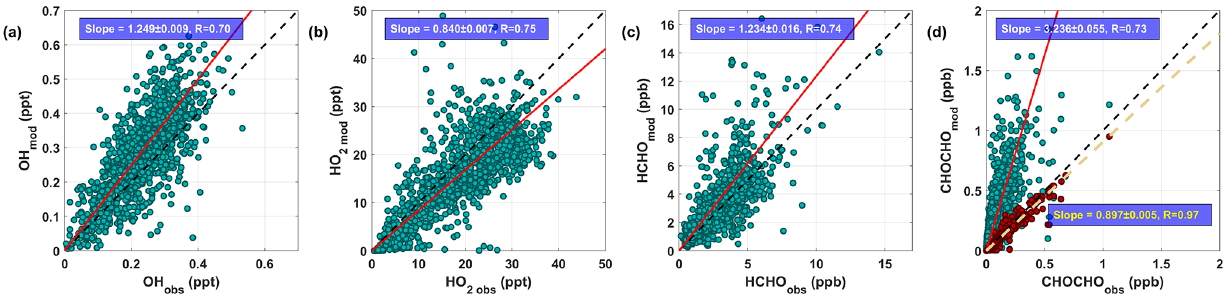
Figure 2. Comparison of measured and modeled (a) OH, (b) HO 2 , (c) HCHO, and (d) CHOCHO without (with) loss to aerosol in green (brown) circles. The dashed black line represents 1:1 line and red (yellow) line is the best orthogonal distance regression (ODR) fit forced through the origin and Pearson R